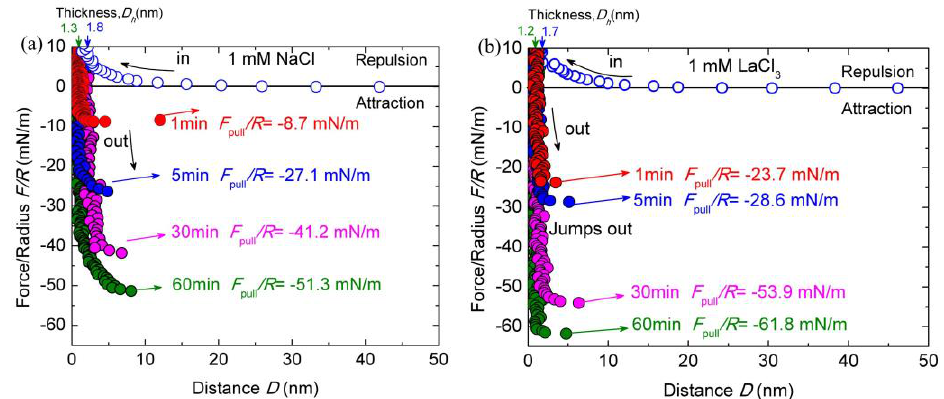
Figure 3. Interaction forces F / R as a function of surface separation D between two chitosan-adsorbed mica surfaces in 100 mM HAc buffer with 1 mM LaCl 3 ( a ) and NaCl ( b ), pH = 3.2. The open and closed symbols indicate the approach and separation of the two surfaces, respectively.